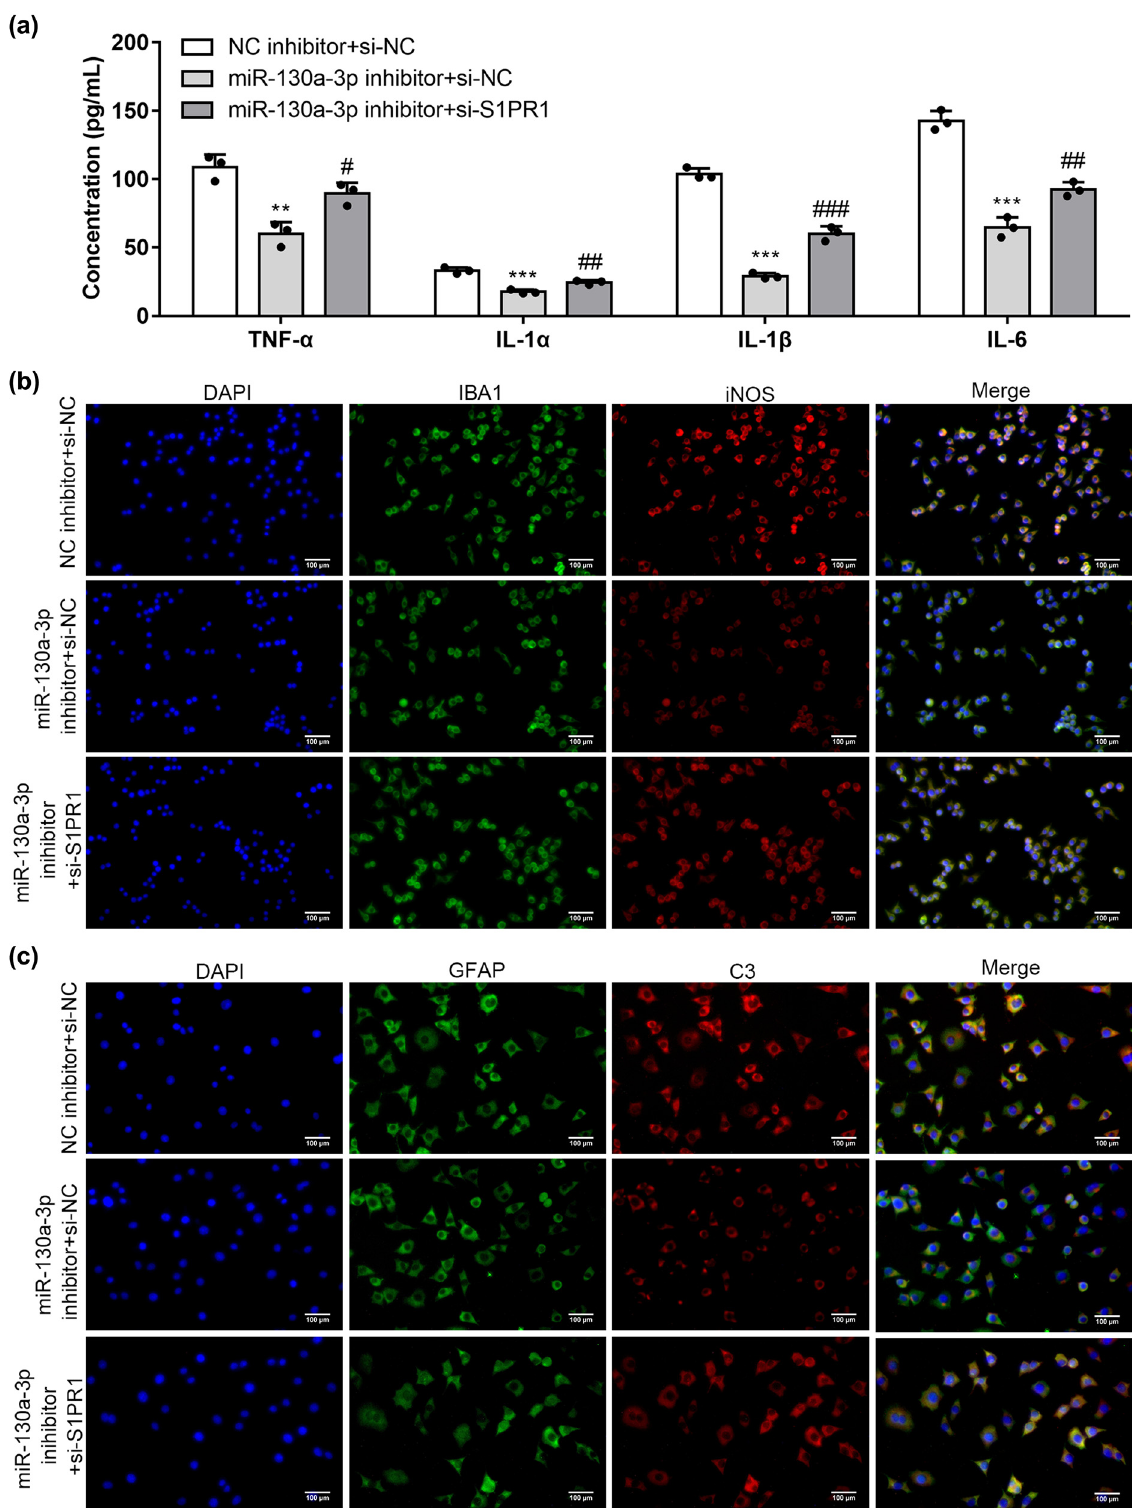
Figure 7: si - S1PR1 rescued the repressive e ff ects of the miR - 130a - 3p inhibitor on activation of the astrocytes and microglial cells. ( a ) Rescue e ff ects of S1PR1 de fi ciency on miR - 130a - 3p de fi ciency in IL - 1 α , TNF - α , IL - 6, and IL - 1 β concentrations in supernatants of microglia were assessed by ELISA. ( b ) Immuno fl uorescence staining of IBA1 and iNOS in microglial cells under the transfection of miR - 130a - 3p inhibitor or cotransfection of miR - 130a - 3p inhibitor + si - S1PR1. ( c ) Immuno fl uorescence staining of GFAP and C3 in astrocytes by treatment of miR - 130a - 3p inhibitor or cotransfection with miR - 130a - 3p inhibitor + si - S1PR1. *** P < 0.001 vs NC inhibitor + si - NC, # P < 0.05, ## P < 0.01, ### P < 0.001 vs miR - 130a - 3p inhibitor + si -